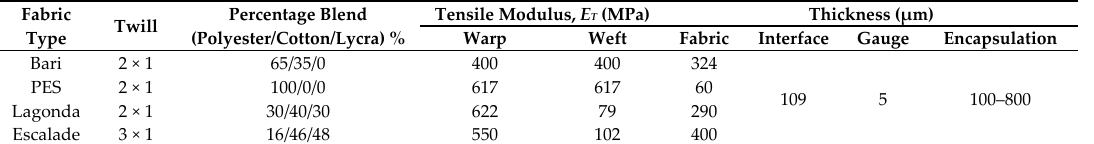
Table 1. Physical properties of fabrics and thicknesses of printed films.